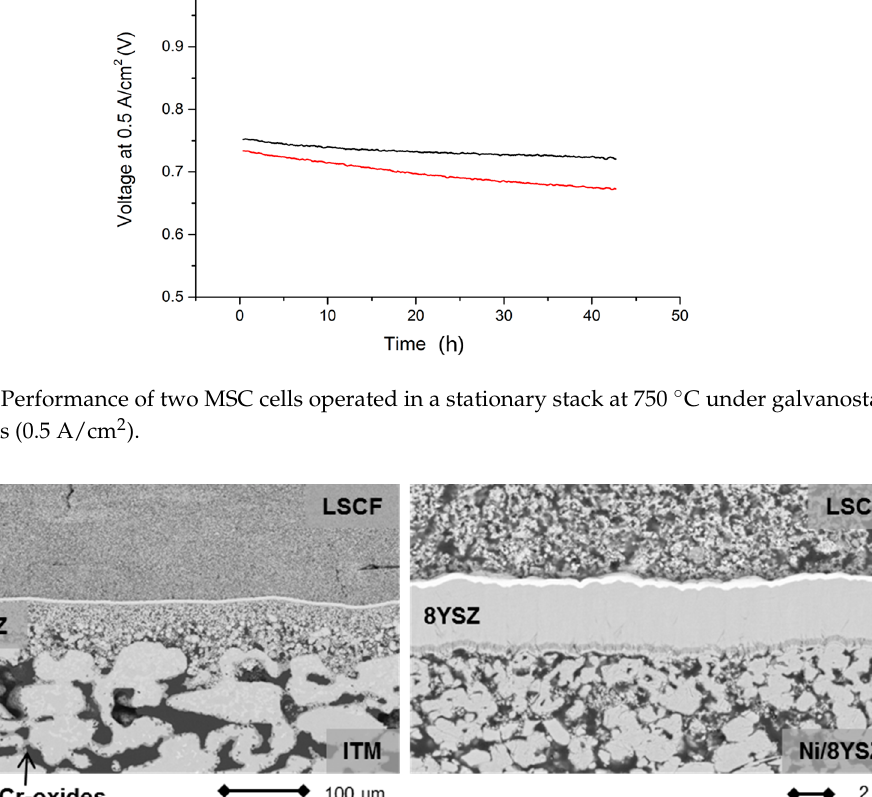
Figure 7. Cross-section of MSC 2 (see Figure 6) after operation in a stationary design.